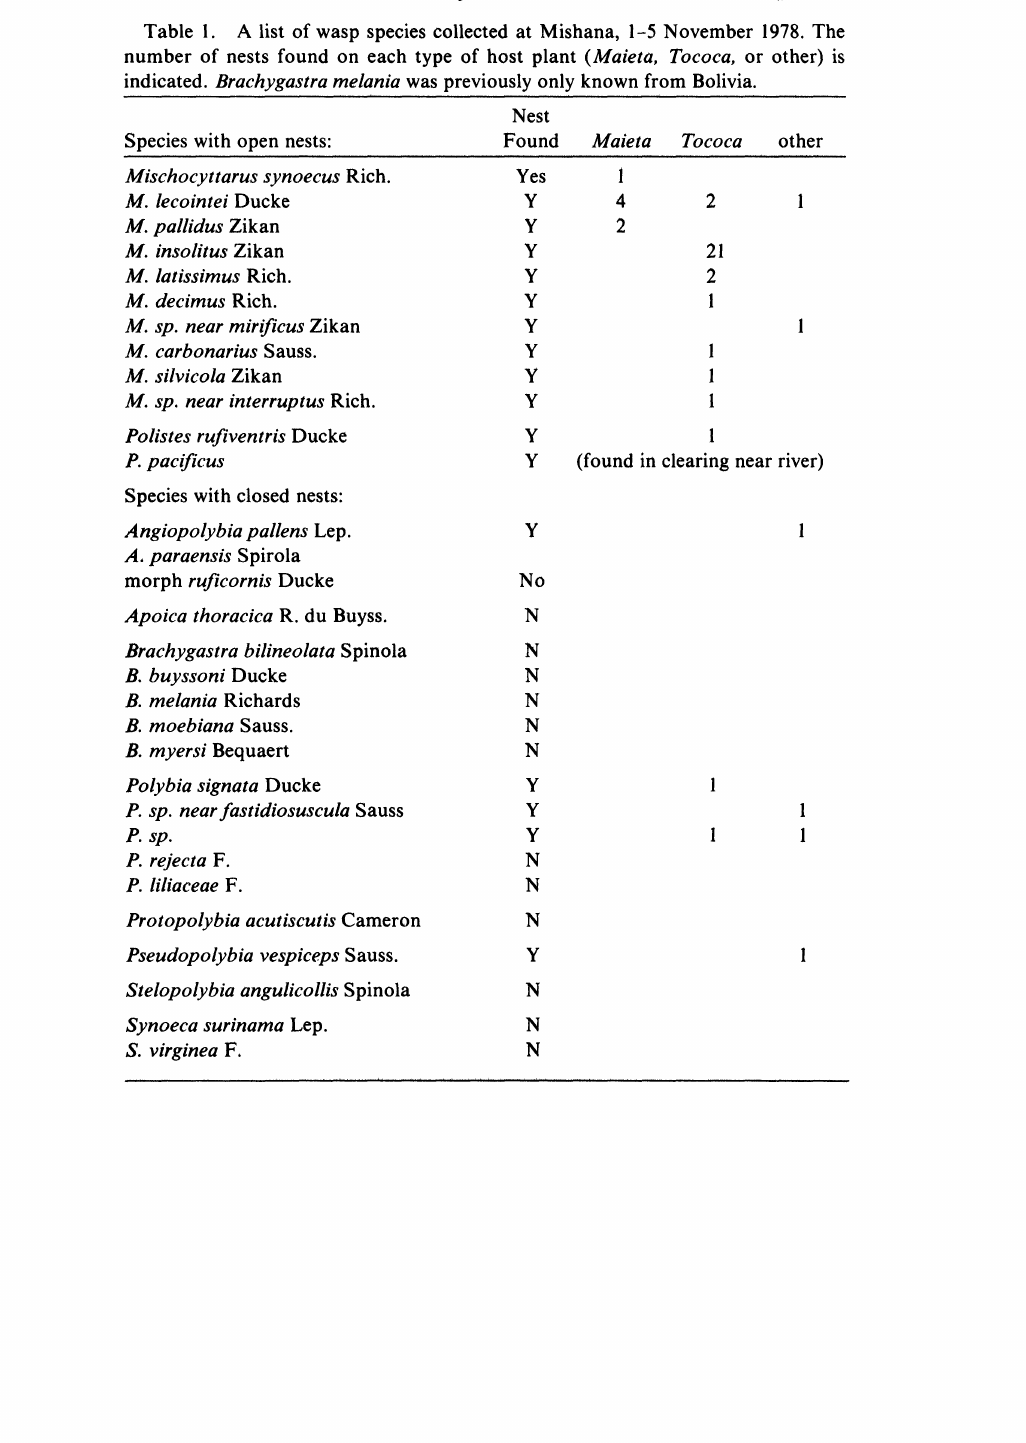
Table 1. A list of wasp species collected at Mishana, 1-5 November 1978. The number of nests found on each type of host plant (Maieta, Tococa, or other) is indicated. Brachygastra melania was previously only known from Bolivia. Nest Species with open nests: Found Maieta Tococa other Mischocyttarus synoecus